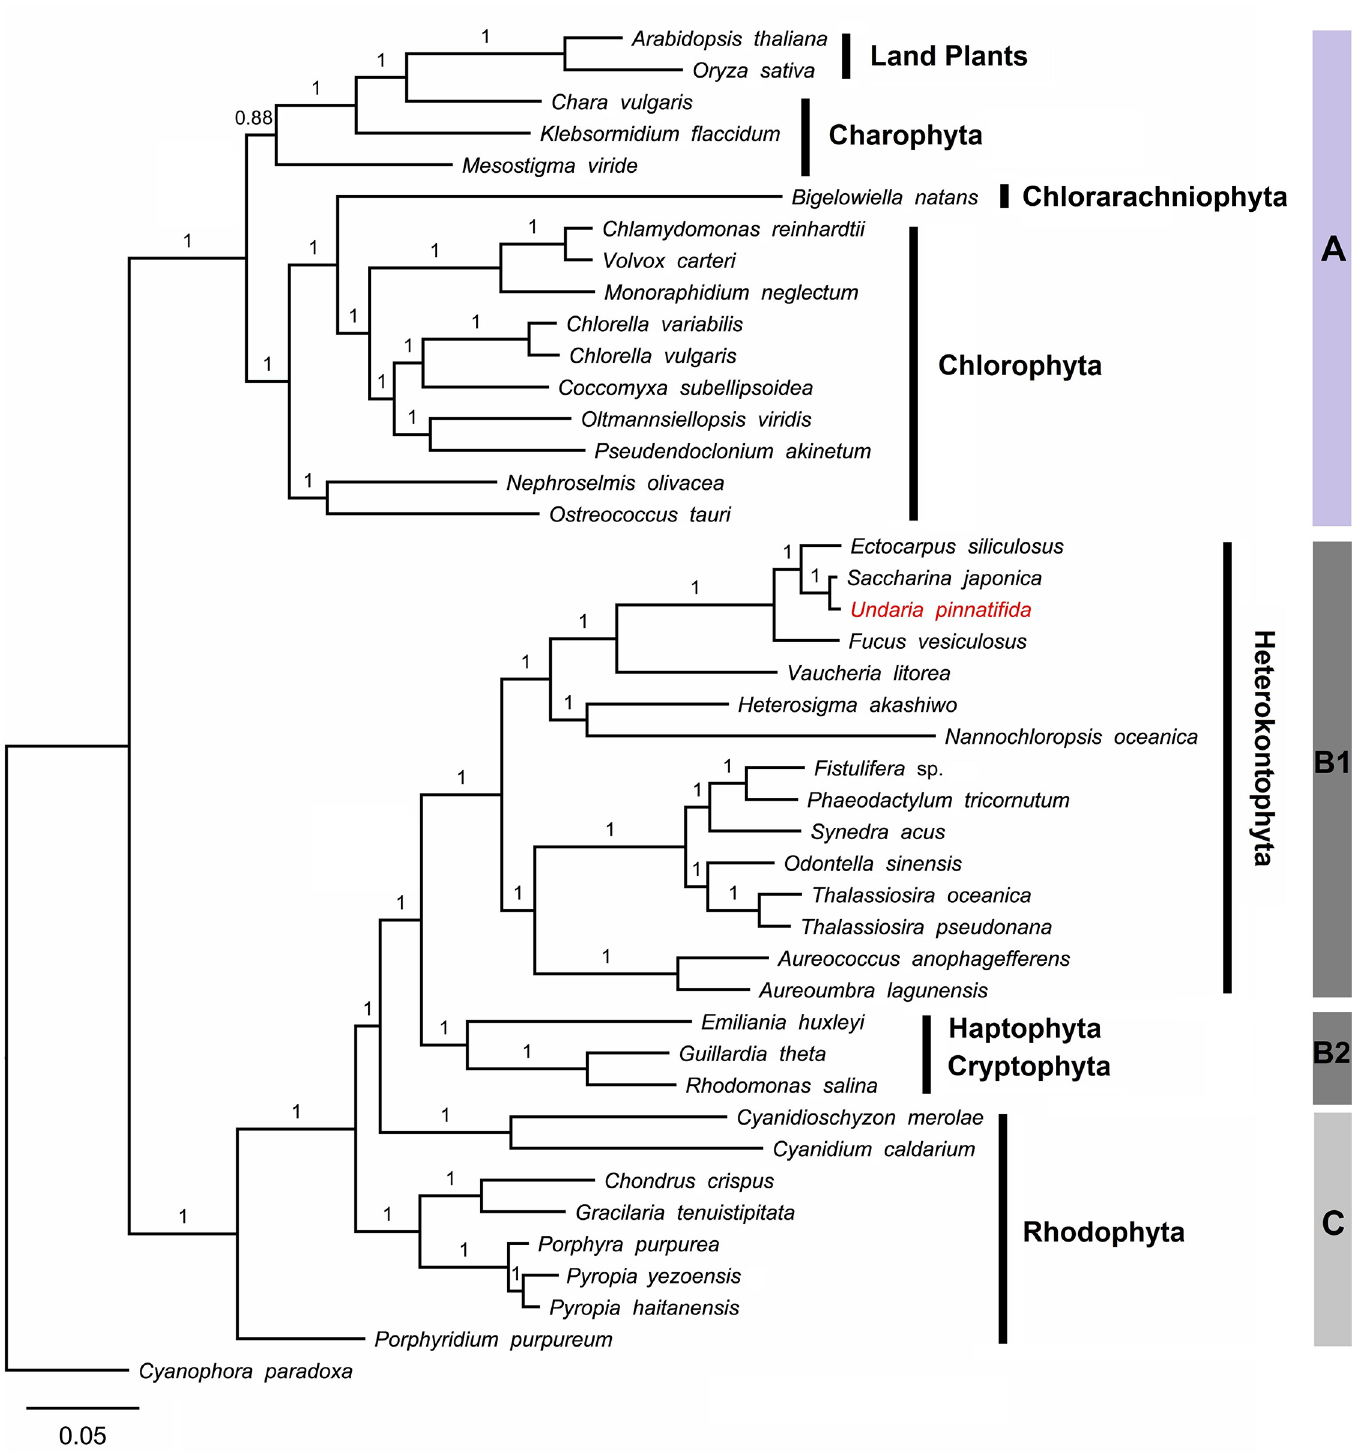
Fig 4. Phylogenetic tree topologies based on 23 plastid protein-coding genes inferred using Bayesian methods.